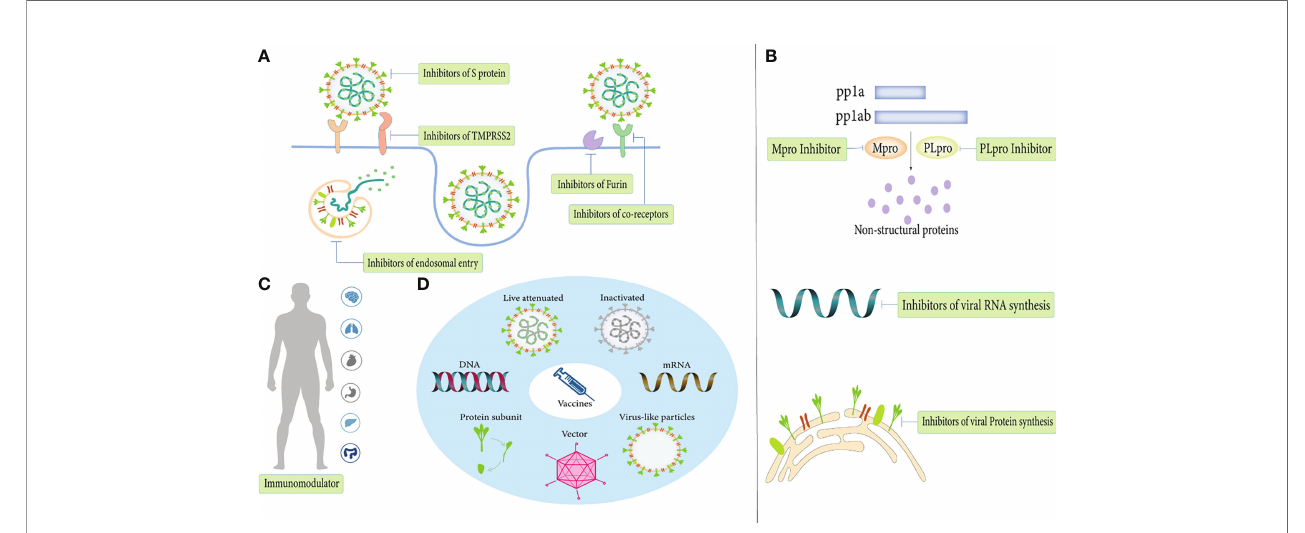
FIGURE 4 | Anti-viral treatments of COVID-19. (A) Inhibit SARS-CoV-2 entry. (B) Inhibit SARS-CoV-2 replication. (C) Immunomodulator. (D)